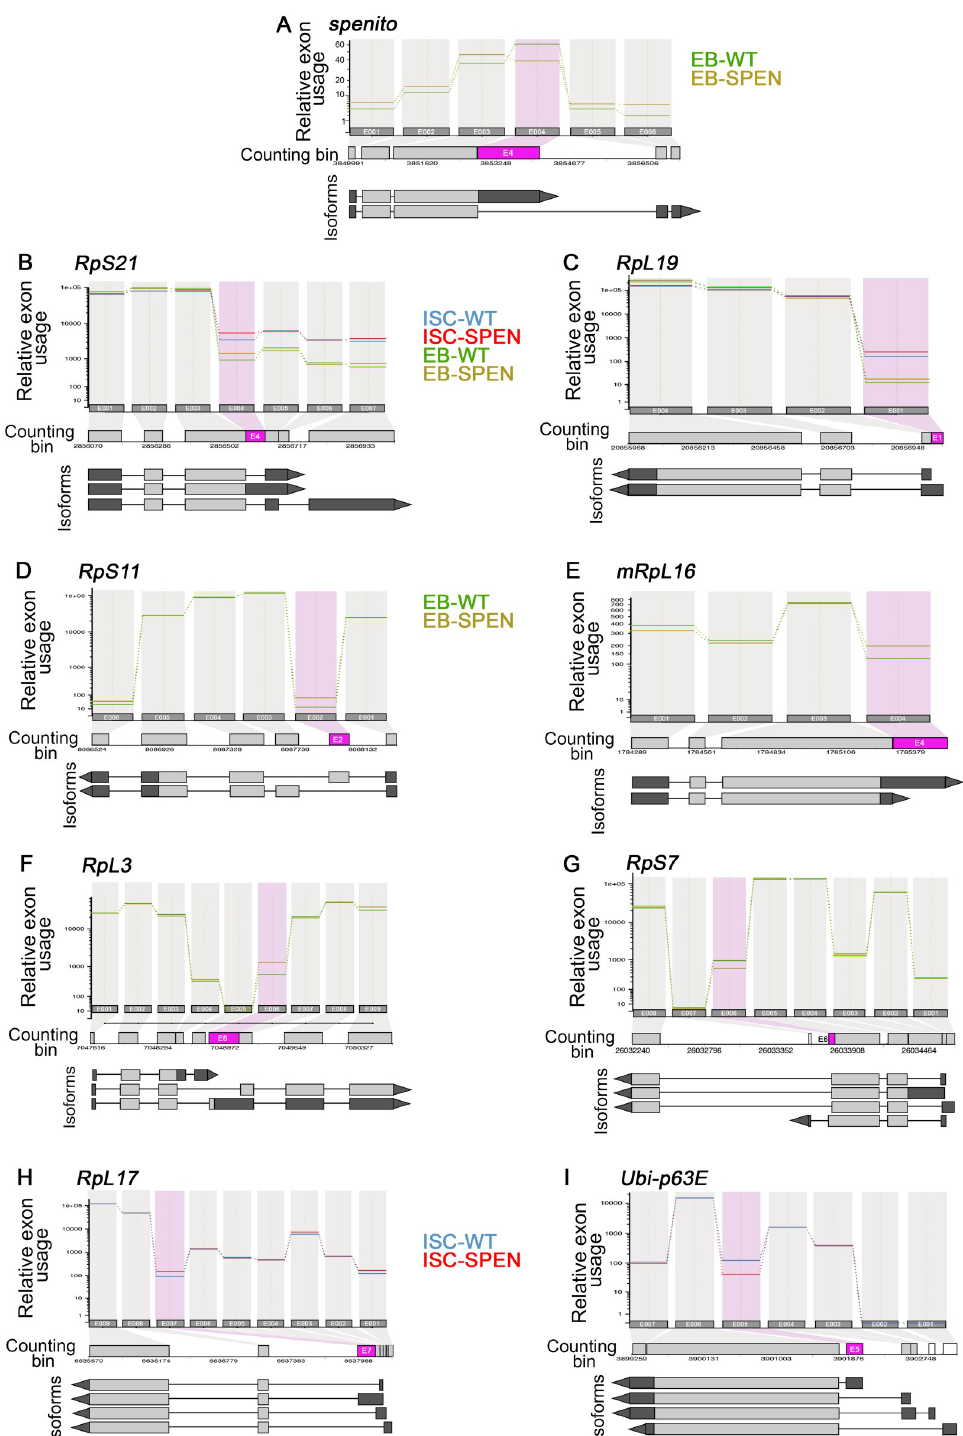
Fig 6. Examples of types of altered exons upon spen knockdown. Visualization of the relative exon usage, in a subset of example transcripts (DEXseq plot): ( A ) The relative exon usage of spenito was affected by spen RNAi in EBs (B) Ribosomal protein encoding transcript RpS21 and (C) RpL19 had exon usage alteration upon spen RNAi in both ISCs and EBs. (D) RpS11, (E) mRpL16, (F) RpL3 and (G) RpS7 showed differential exon usage in spen knock-down EBs. Additional examples of splicing could be found upon spen RNAi expression in ISCs: within (H) RpL17 and (I) Ubi-p63E